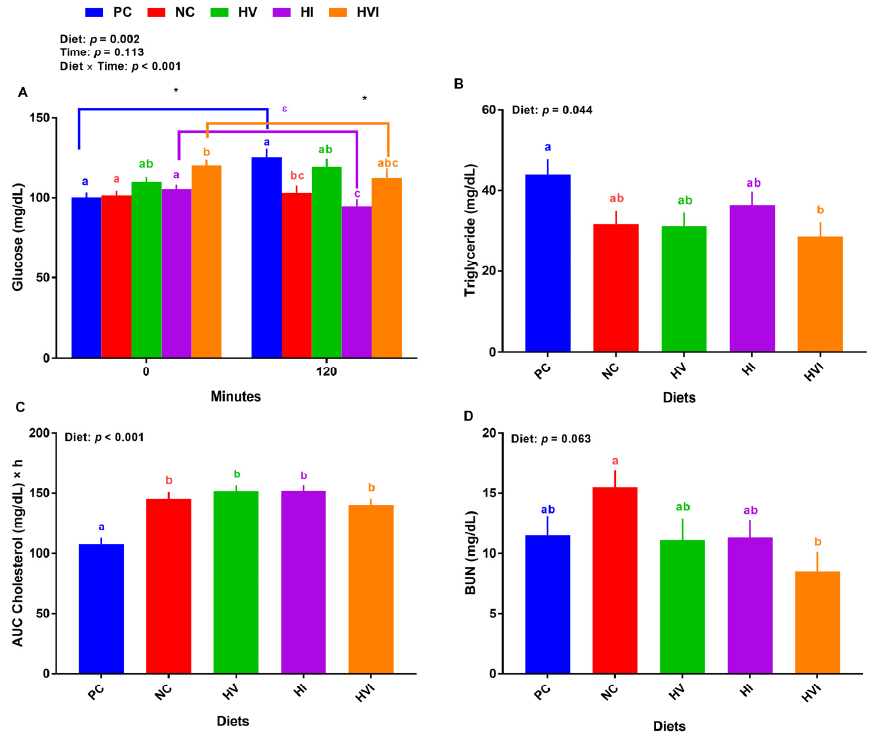
Figure 3. Plasma metabolite of nursery pigs fed with very low protein diets containing isoleucine (Ile), valine (Val), or mix of both above NRC levels. ( A ) glucose concentration at baseline (0 min) and 120 min after meal, ( B ) triglyceride concentration, ( C ) area under the curve (AUC) for cholesterol, and ( D ) blood urea nitrogen (BUN). PC: positive control, standard protein diet; NC: negative control, very low protein diet containing the first four limiting amino acids (i.e., lysine, methionine, threonine, and tryptophan) at NRC levels; HV: NC containing Val above NRC level; HI: NC containing Ile above NRC level; and HVI: NC containing both Val and Ile above NRC level. The values are means ± standard error of the mean. n = 8. a,b,c,ab,bc,abc Among groups, the means with different superscript letter(s) are different ( p ≤ 0.05). * p ≤ 0.05 0 min vs. 120 min; ε p ≤ 0.1 0 min vs. 120 min.